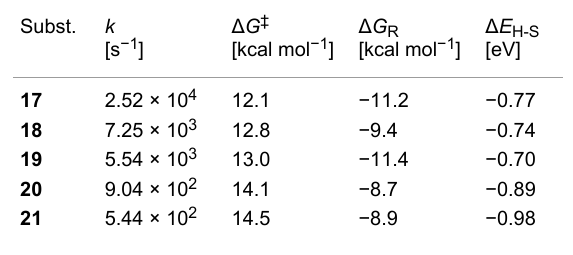
Table 5: Calculated kinetic and thermodynamic data (on the PW6B95- D3/QZVP//TPSS-D3/def2-TZVP level) and HOMO–SOMO gap Δ E H-S (on the TPSS-D3/TZVP level) of the reactions of 17 – 21 in benzene at 40 °C. Subst.